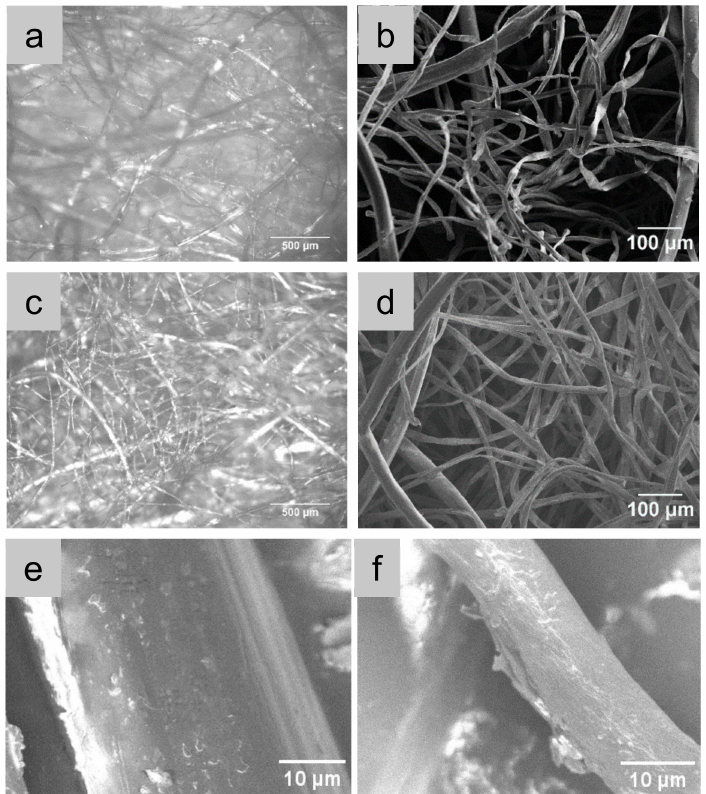
Figure 3. Morphologies of cotton/PLA nonwoven mat and the GO-coated cotton/PLA nonwoven mats. ( a , b ) Optical and SEM images of CP, respectively; ( c , d ) optical and SEM images of CP_0.38GO, respectively. ( e , f ) GO-coated PLA fibre and cotton fibre,